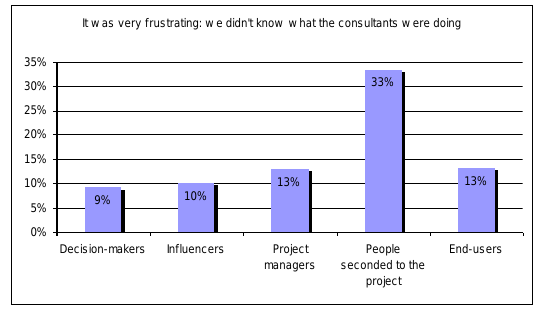
Figure 4 : But Frustration does Cascade Down the Organisational